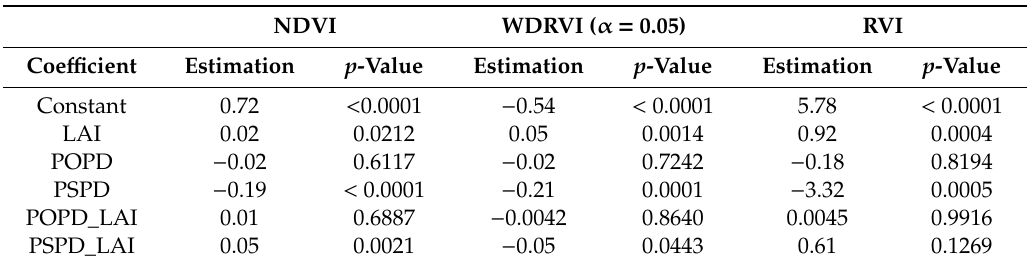
Table 5. Linear regression parameter estimations and significance for all data, separated with auxiliary variables and unprotected canopy values as the